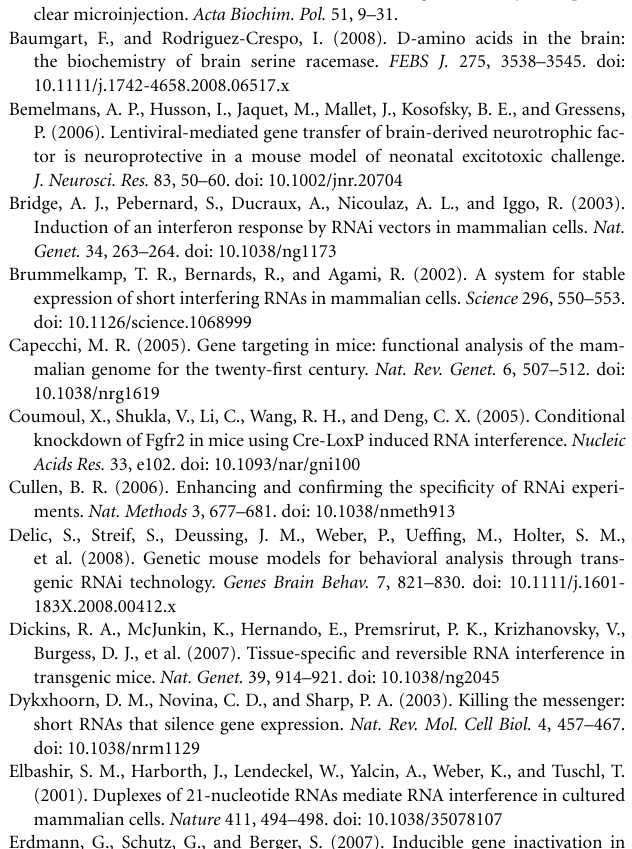
Table S1 | Double-stranded siRNAs and oligonucleotides for SR silencing. (A) Four different siRNAs (1–4) complementary to SR mRNA sequence (target) were designed. Sense and antisense siRNAs are represented. siRNA Alexa Fluor 488 negative control: siRNA with no homology to any known mammalian gene and labeled with Alexa Fluor 488 fluorescent dye for transfection monitoring and optimization. (B) siRNA3 and siRNA4-based oligos 3 and 4 with targeted SR cDNA sequence. Sense and antisense sequences for shRNA expression with loop sequence TTCAAGAGA and 5 (cid:4) terminal Ts (on sense strand). Predicted sense and antisense siRNAs after shRNA processing are in bold. Scrambled oligo coding for an shRNA not targeting any mammalian gene was used as negative control. Table S2 | Germline transmission of the proviral transgene pSico-shRNA3 in pSico-shRNA3 × GFAP-CreERT2, CaMKII α -CreERT2, and CaMKII α -Cre mice. The yield of PCR-positive and PCR-negative mice is presented as a ratio with the corresponding percentage of pSico-shRNA3 and CreERT2 or Cre transgene segregation. (A) Eight mouse lines were obtained from pSico-shRNA3 × GFAP-CreERT2 F0 founders (5 females and 2 males) and backcrossed down to 5 generations. (B) Transgene segregation in pSico-shRNA3 × CaMKII α -CreERT2 (F1–5) and pSico-shRNA3 × CaMKII α -Cre mice (F1–3). F1 pSico-shRNA3 × CaMKII α -CreERT2 mice (line 1 and 2) were generated by breeding pSico-shRNA + /GFAP-CreERT2 − F2 mice to CaMKII α -CreERT2 mice (line 1302 females). F1 pSico- shRNA3 × CaMKII α -CreERT2 mice (line 1) were generated from pSico-shRNA + /GFAP-CreERT2 − F4 mice (two line 2 females) bred to a CaMKII α -Cre mouse (line 2834 male). The pSico-shRNA3 construct was reliably transmitted in F1–F5 progeny, indicating stable integration and effective transmission across